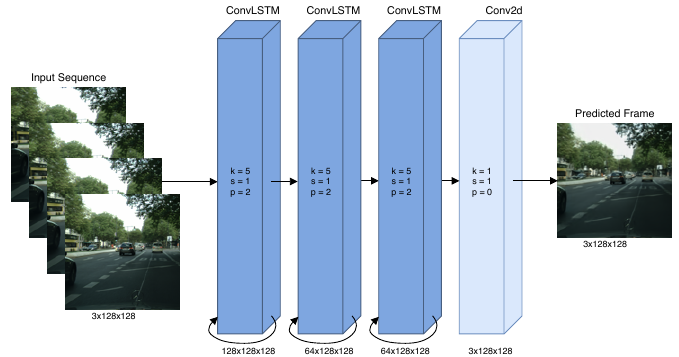
Figure 2. Resolution preserving three-layer convolutional long-short term memory (ConvLSTM) next frame prediction